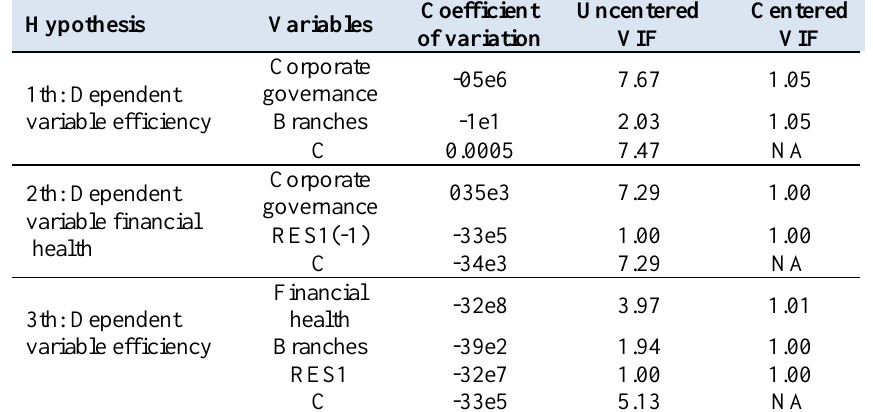
Table 6. Variance inflation factor (VIF) test results to examine the alignment relationship